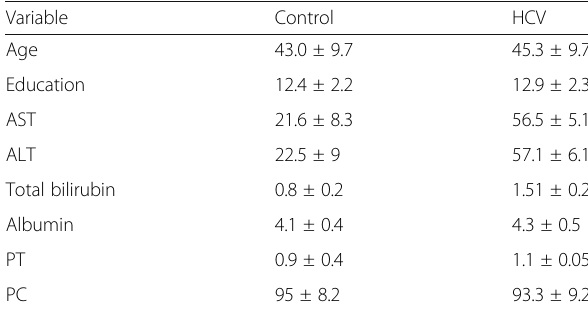
Table 1 Demographic characteristics and liver function of the studied groups